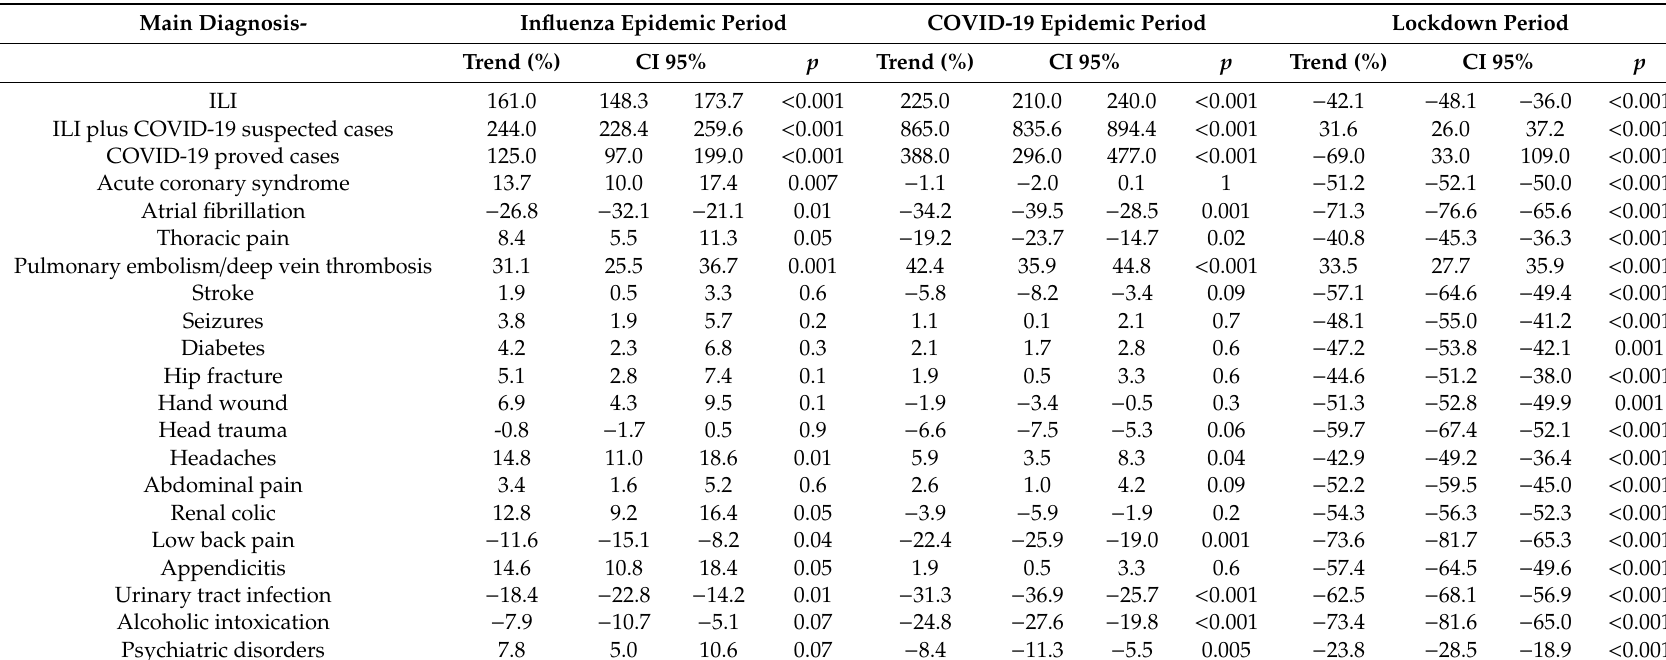
Table 4. Trends in main diagnosis groups during 2019 and 2020 study periods compared to the 2018–2019 period (pre-study period). Main